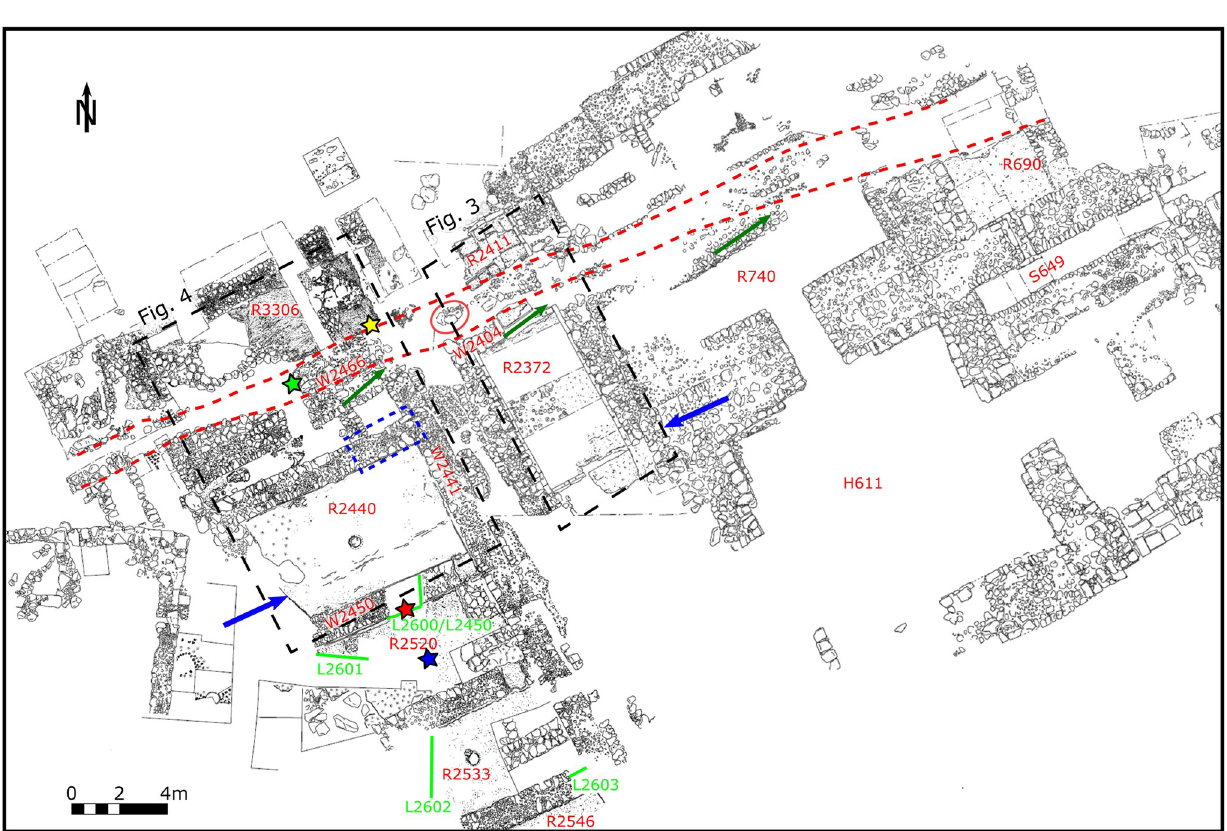
Fig 2. Plan of Phase III at Tel Kabri. Text starting with R indicates room numbers mentioned in text; W indicates wall locus numbers. Red circle indicates the location of an Iron Age pit, while red dashed line is the trace of the trench mentioned in the text. Green numbers beginning with L indicate loci where sediment samples were collected for micromorphology and FTIR analysis and green lines show the location of excavation profiles sampled. Blue arrows point to the warped floor in Room 2440 and offset walls of the Orthostat Building, which are aligned and parallel to the trace of the Kabri fault and to the trench. Note that structures located just south of the trench are misaligned with respect to the general trend of palace walls, with their northwestern corners rotated towards this feature (dark green arrows). Green star marks the approximate location of Fig 5a. Yellow star marks the approximate location of Fig 5b. Red and blue stars indicate the location of images presented in S1 Fig. Dashed black rectangles show location of Fig 3 (the Orthostat Building) and Fig 4a (the Southern and Northern Wine Storage Complexes), while dashed blue rectangle marks the location of Fig